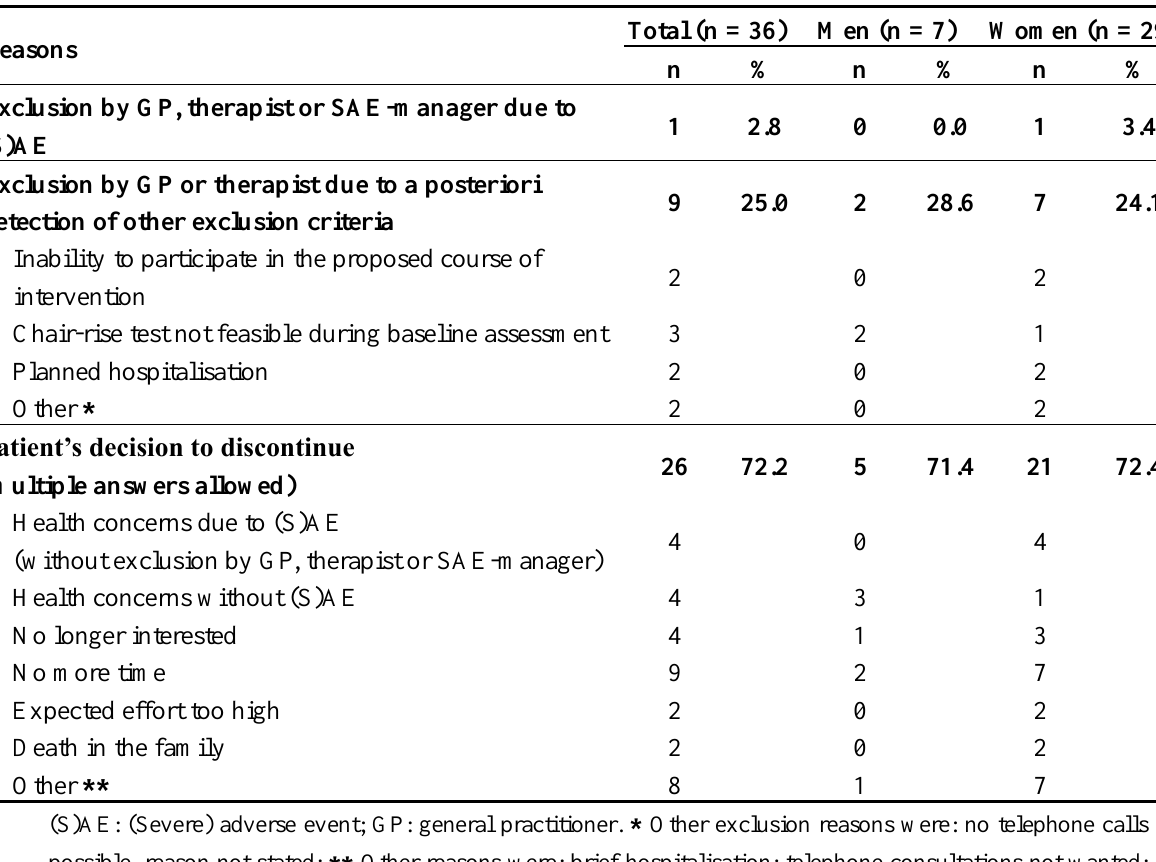
Table 5. Reasons for discontinued participation before